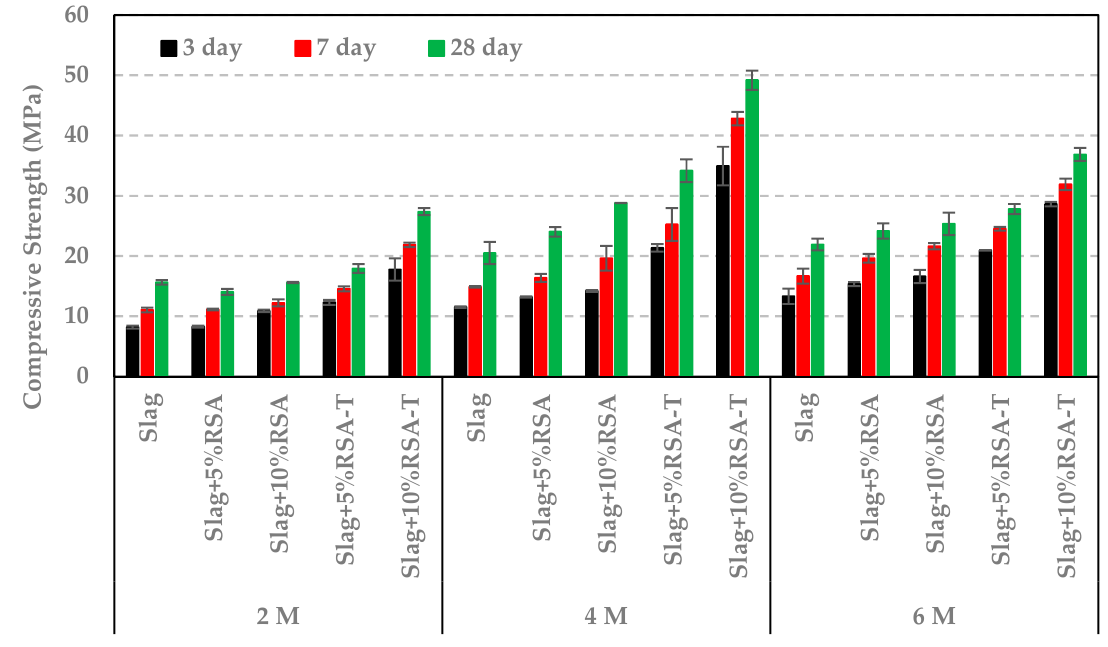
RSA or RSA-T. This can be attributed to the higher silica content of RHA compared to RSA (see Table 1). Nevertheless, treated RSA or RHA (RSA-T or RHA-T) significantly increased the compressive strength compared to untreated ash samples.